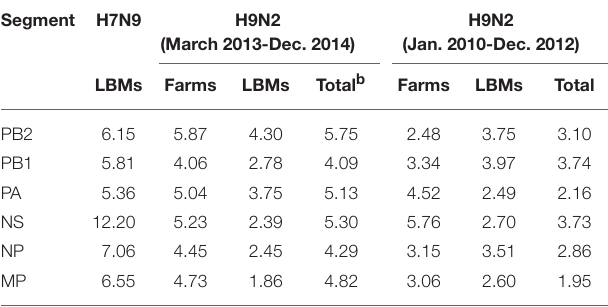
TABLE 1 | Mean substitution rates a of avian influenza samples isolated in different time periods and